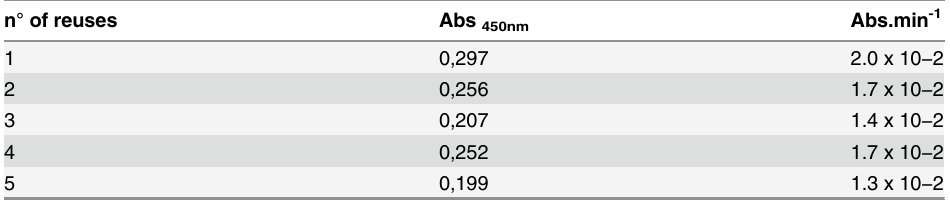
Absorbance was measured after 15 minutes of reaction at 450 nm. After each reaction beads were washed with dimethyl sulfoxide and then